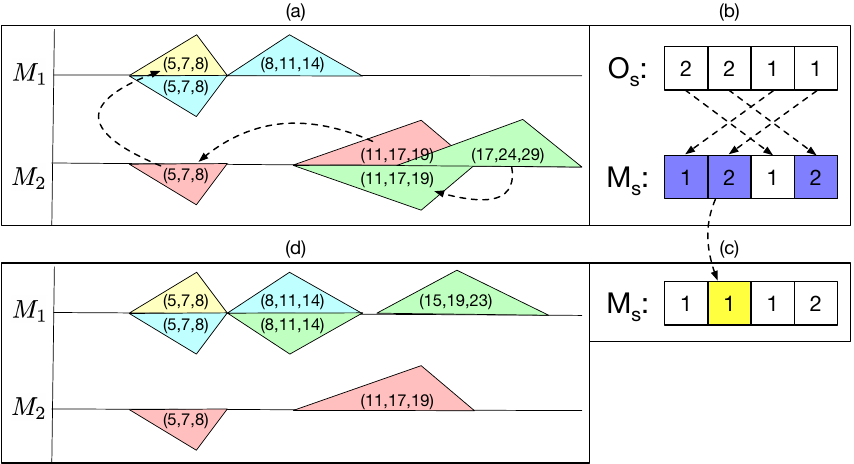
Figure 4. Machine change in a critical operation during the hill climbing. ( a ) Backtracking of critical operations. ( b ) Machines assigned to critical operations. ( c ) Machine change in a critical operation. ( d ) New fuzzy